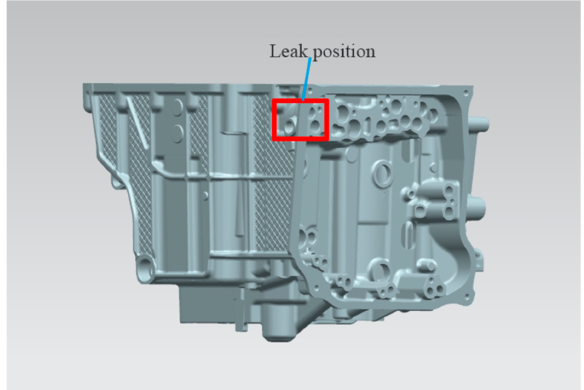
Figure 10. Measured leakage position of the finished gearbox